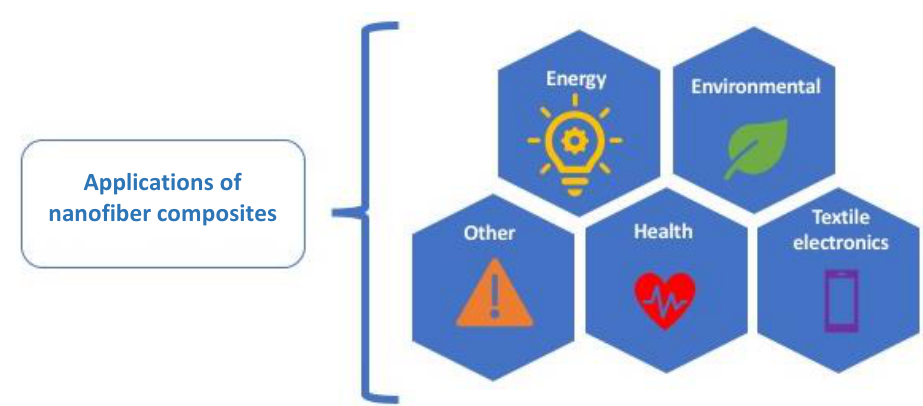
Figure 1. Various applications of electrospun nanofiber composites: environmental, health, energy, textile electronics, and other.